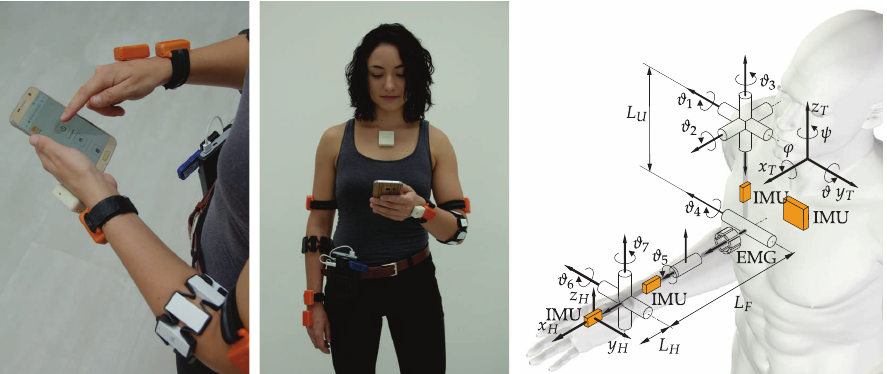
Figure 2. Wearable system for measurement of activities of daily living and kinematic model of the upper limb with sensor placement: IMU sensors (orange) and EMG bracelets (white segmented